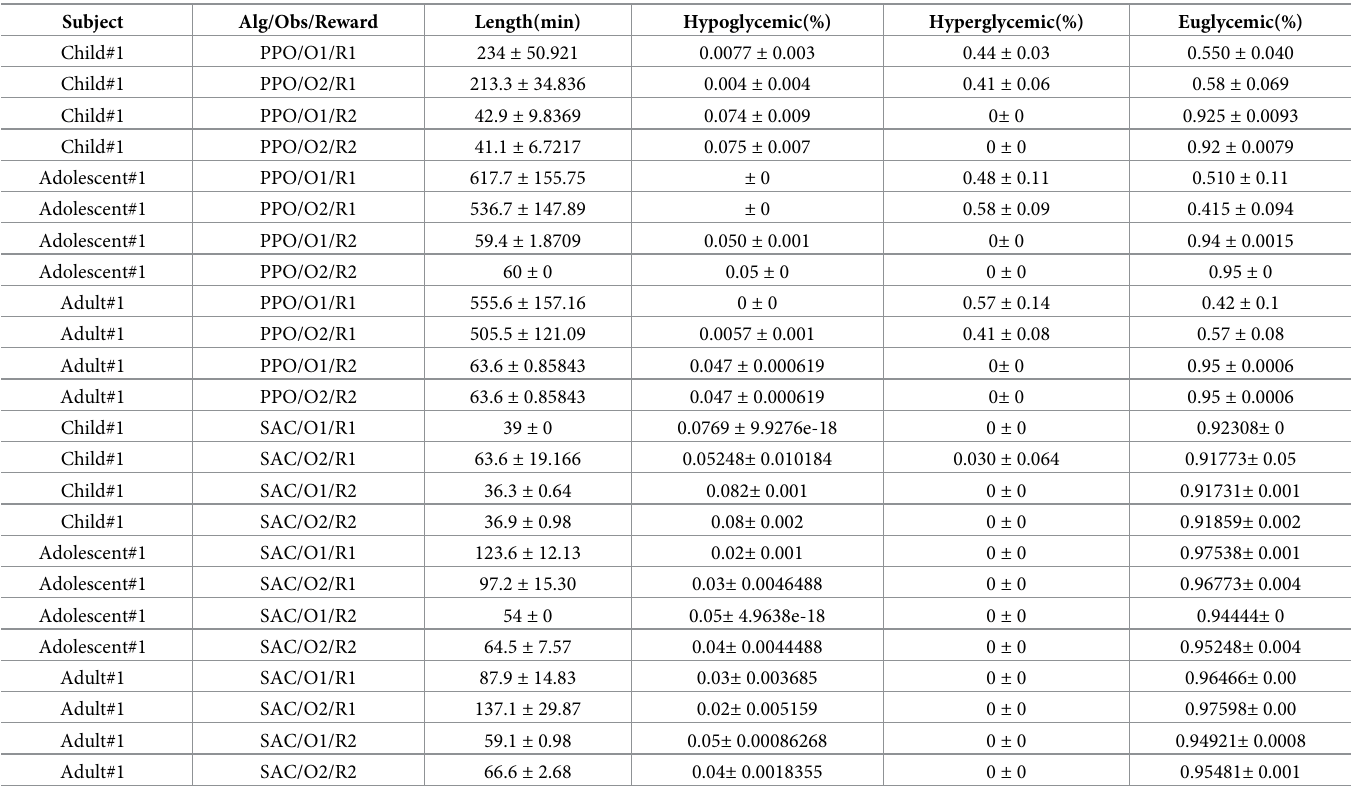
Table 1. Summary of initial evaluation. All columns show average ± 95% confidence